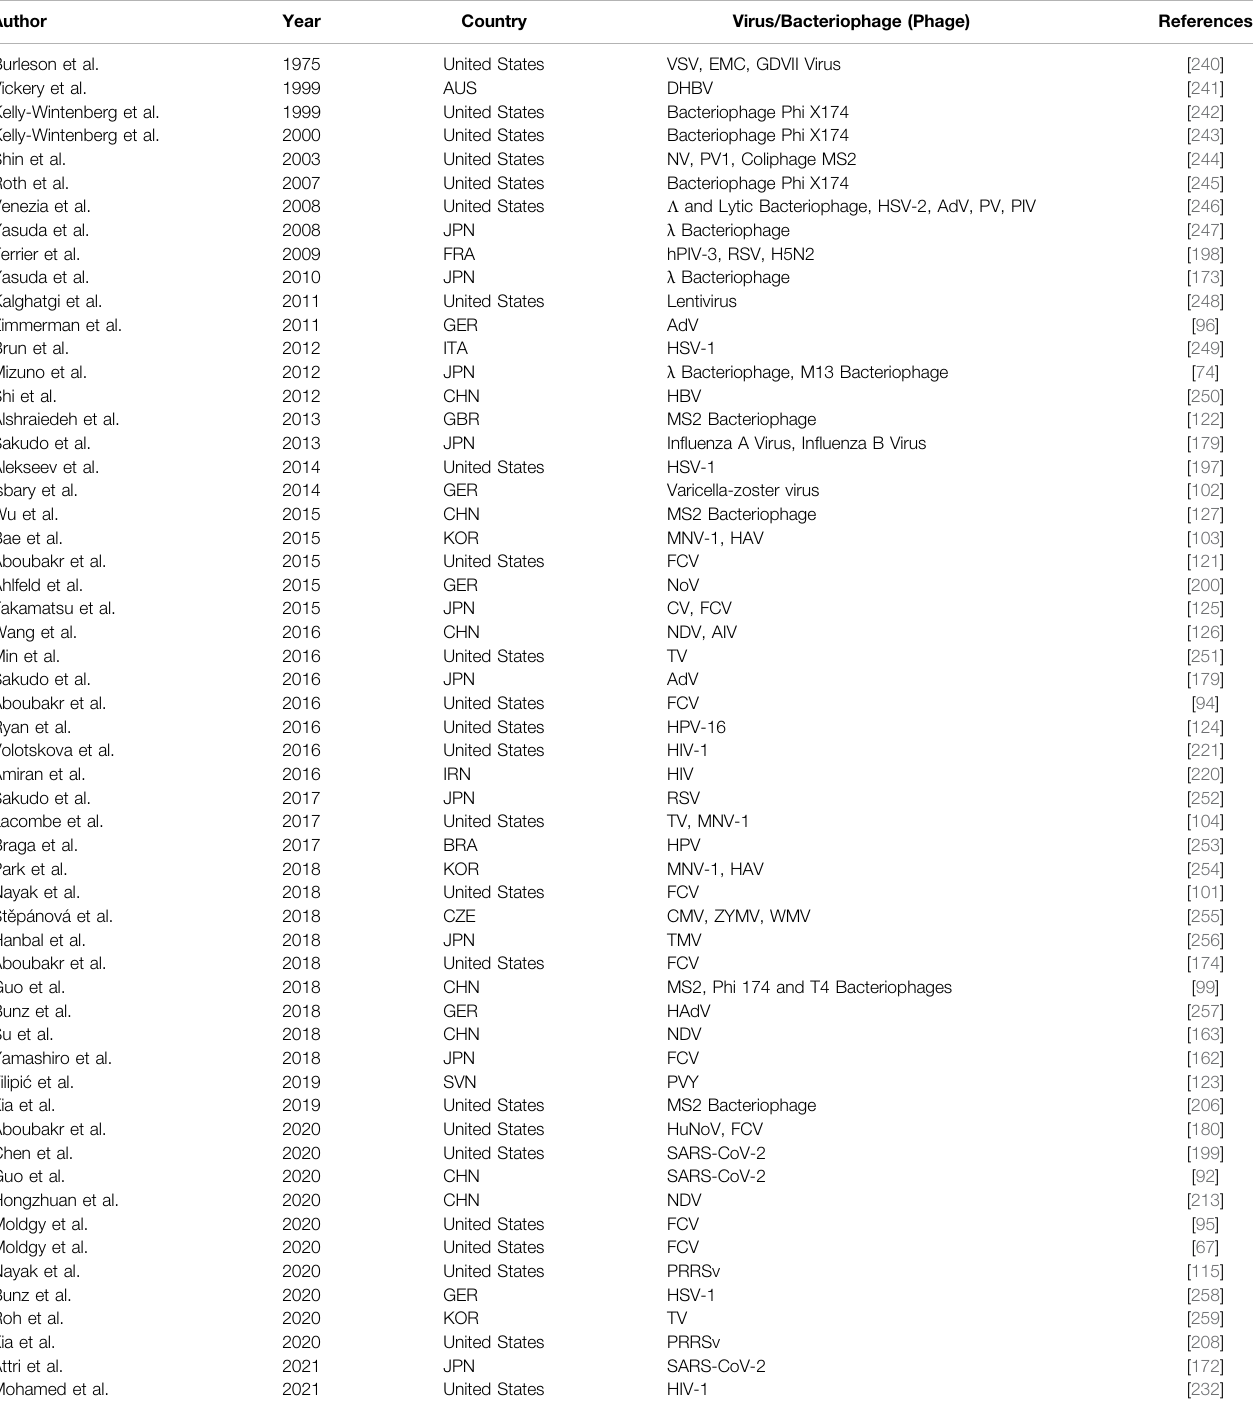
TABLE 1 | Compilation ofstudies investigating antiviral effects of NTP. These studies used either infectious human viruses or surrogate viruses toevaluate the antiviraleffect of NTP.